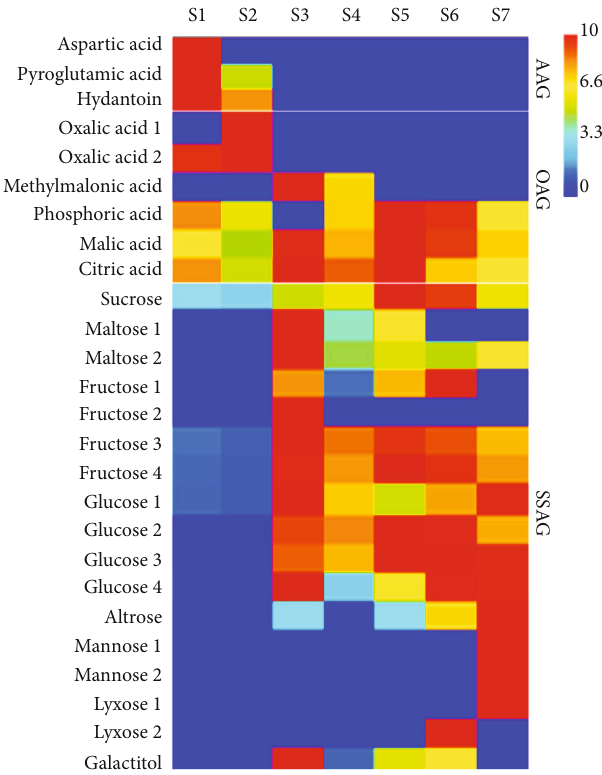
Figure 3: Polar metabolite levels, representatives of the major groups that changed during the development of the Agung Semeru plantain fruits. The amounts were based on the area of each peak which was normalized to the dry weight of each ripening stage (area/g). The ratio of the metabolite content at each ripening stage to the average metabolite content across the seven ripening stages is shown by the colour scale; the lowest ratio is in dark blue, and the highest ratio is in dark red. AAG=amino acid group; OAG=organic acid group; SSAG=sugar and sugar alcohol